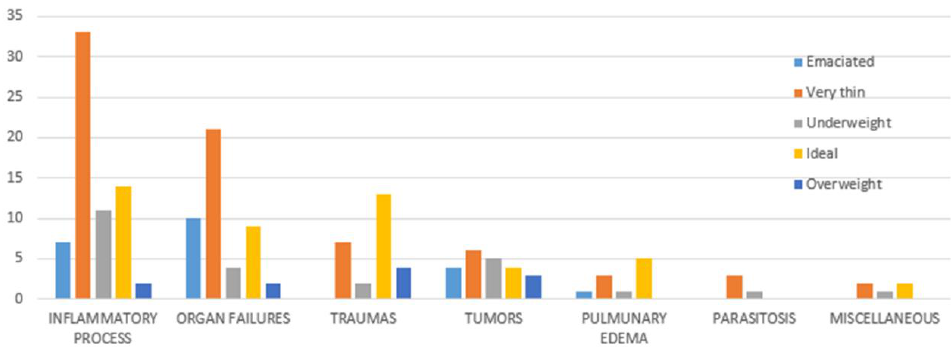
Figure 5. Relation between cause of death and body condition of colony cats included in the study. The logistic regression model (R 2 = 0.397, n = 87), similar to the chi-square test, showed that only age ( p = 0.00467) and body condition ( p = 0.0209) were statistically significant. No statistical effect was observed for neutering with this model, even if a statistically significant difference was observed with the chi-square test considering only the interaction between cause of death and neutering. This result is mainly associated with a confounding effect due to the different ages of non-neutered and neutered cats. In fact, as reported in Figure 6, cats that died from inflammatory processes were mainly kittens (non-neutered), and cats affected by organ failure were frequently old and thus generally